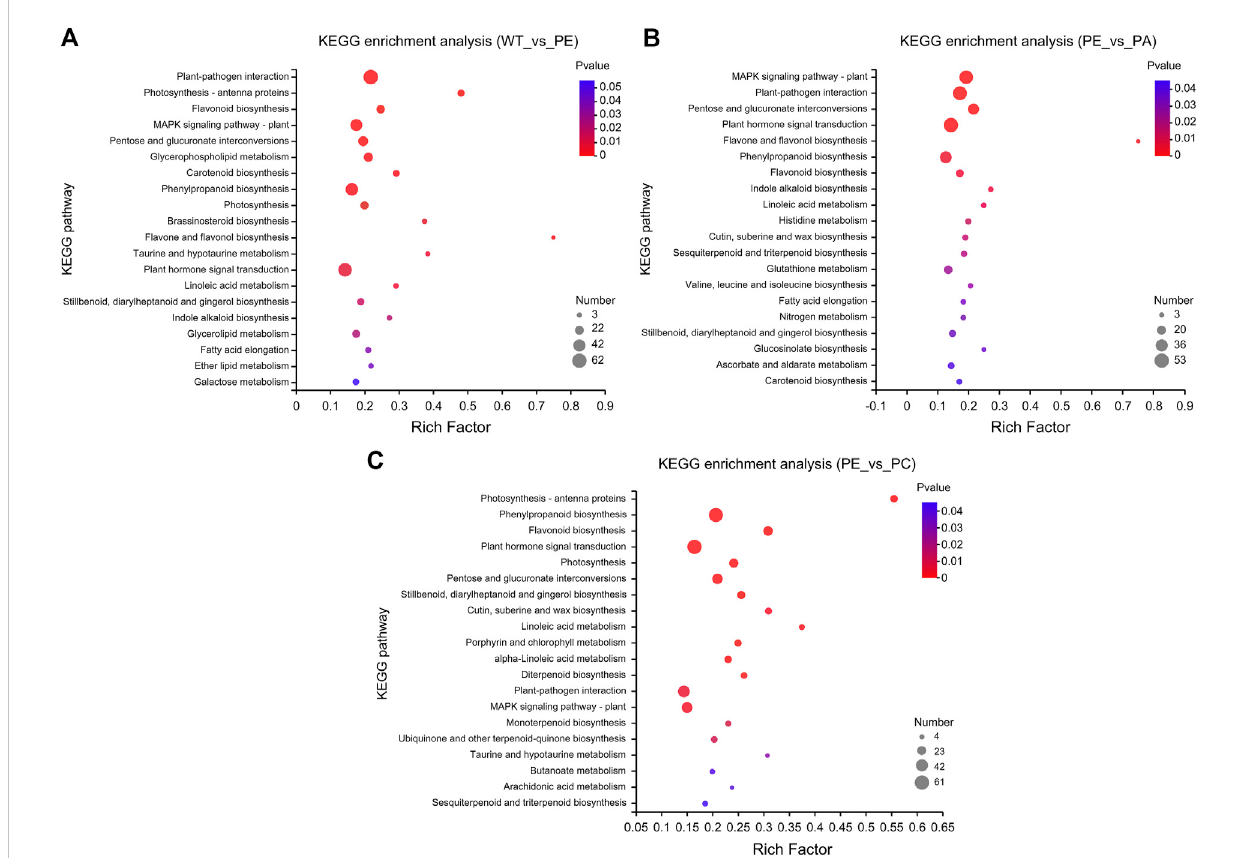
FIGURE 5 Kyoto encyclopedia of genes and genomes (KEGG) pathway enrichment of DEGs. KEGG pathway enrichment bubble charts of (A) WT_vs._PE, (B) PE_vs._PA, and (C) PE_vs._PC comparison groups, respectively. The abscissa represents the enrichment factor, and the ordinate represents the pathway name. The enrichment factor represents the ratio of the DEG numbers annotated in the pathway term to all gene numbers annotated in that pathway term.Thegreatertheenrichmentfactor,thegreaterthedegreeofpathwayenrichment.Thebubblesizesrepresentthenumberofgenesenrichedin the KEGG pathway. The bubble color represents the p